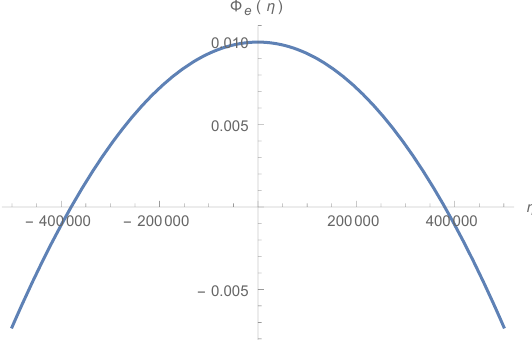
Figure 12. Time evolution of Φ e in the Jordan frame for the initial conditions Φ e ( 0 ) = 10 − 2 , Ψ e ( 0 ) = 1, Φ (cid:48) ( 0 ) = 0, Ψ (cid:48) ( 0 ) = 0. The background evolution is the one obtained by assuming the same initial e e conditions as mentioned in the caption of Figure 2.